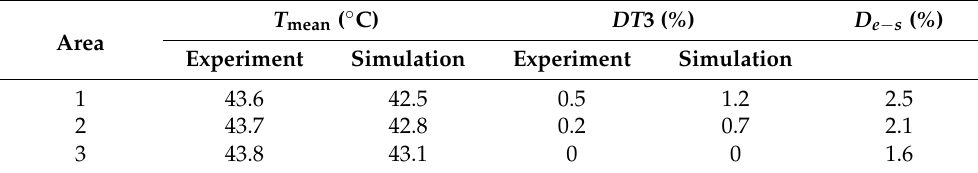
Table 10. Comparison between measured and theoretical temperatures of three heating areas.